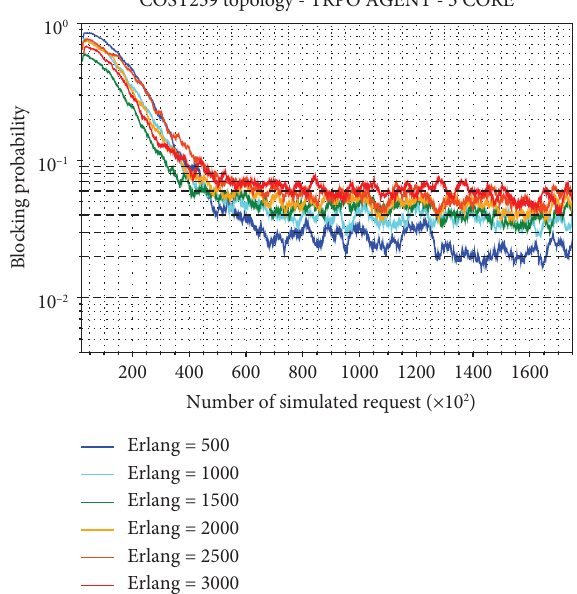
Figure 8: Blocking probability progress for TRPO agent training in COST239